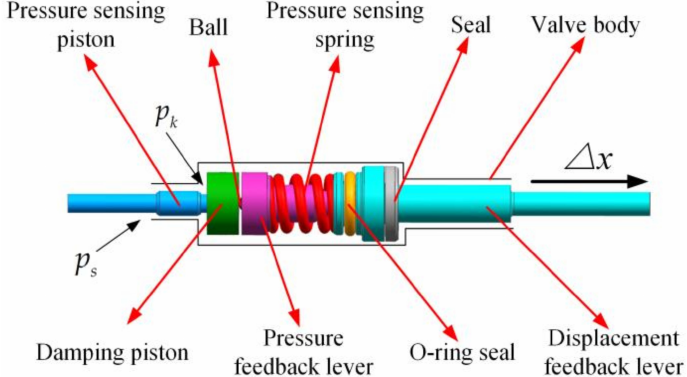
Figure 3. Schematic diagram of differential pressure feedback